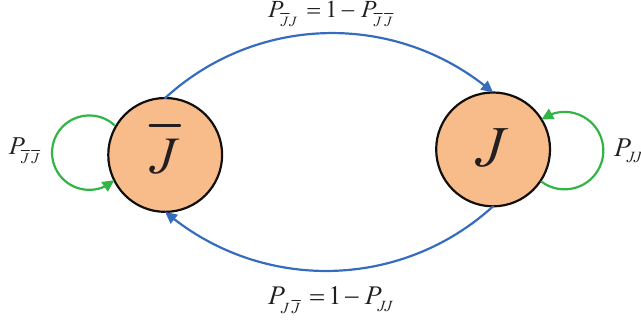
Figure 3. A Markov chain model of the